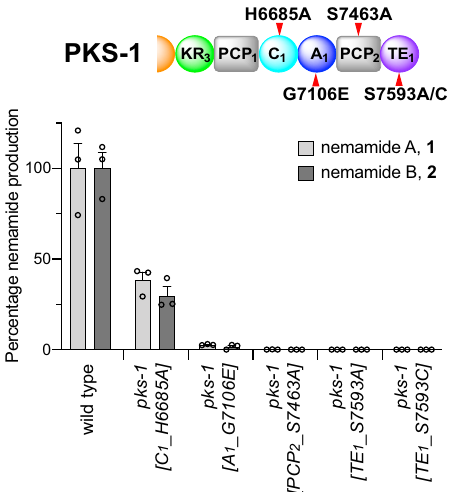
Fig. 3 Analysis of nemamide production in mutant strains in which different domains in the C-terminal NRPS module of PKS-1 have been inactivated. The C-terminal NRPS module was inactivated by mutating essential residues in each domain. In the C 1 domain, the catalytic residue His 6685 was mutated to Ala. In the A 1 domain, Gly 7106, which is essential for cofactor binding, was mutated to Glu. In the PCP 2 domain, the site of phosphopantheinylation, Ser 7463, was mutated to Ala. In the TE 1 domain, Ser 7593, which is part of the catalytic triad, was mutated to either Ala or Cys. The domains that were mutated are indicated with a red tick mark. Domain abbreviations: ketoreductase (KR), peptidyl carrier protein (PCP), adenylation (A), condensation (C), thioesterase (TE). The amount of nemamide A or B in each strain relative to the amount of nemamide A or B in wild-type worms was based on the UV absorbance of the compounds and was normalized by the total mass of dried worms used for extraction. Data represent the mean ± SEM, n = 3 independent experiments in which worms obtained from a culture were extracted for nemamide analysis. Source data are provided as a Source Data fi